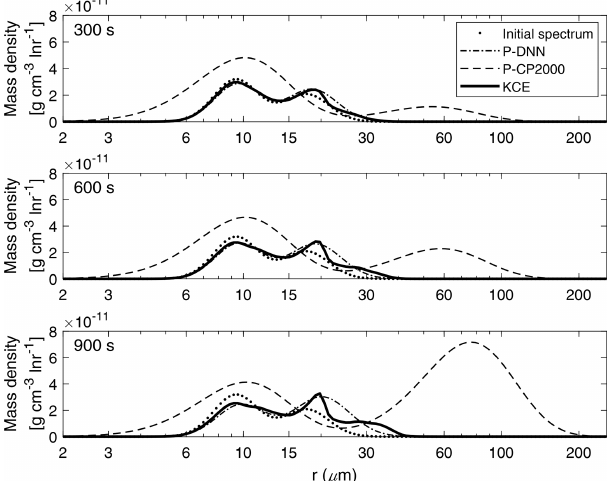
Figure 7. Mass density functions from P-DNN, P-CP2000 and KCE. The represented times are 300, 600 and 900s from top to bottom. Equation (16) was used to transform the drop number con- centration spectra from P-DNN to the mass density